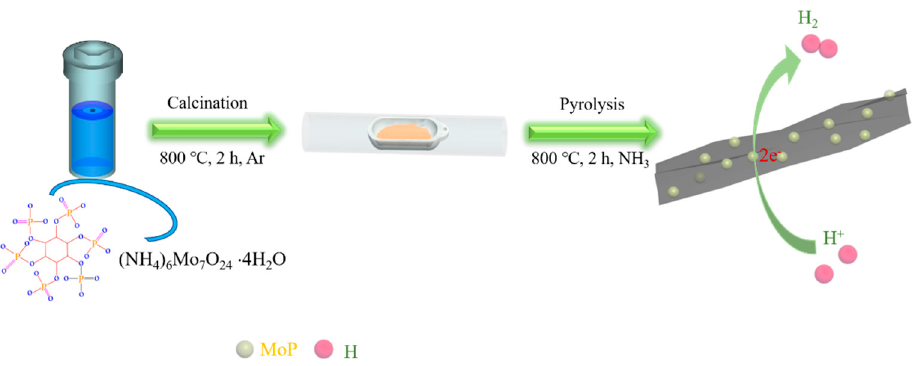
Scheme 1. Schematic illustration for the synthesis of